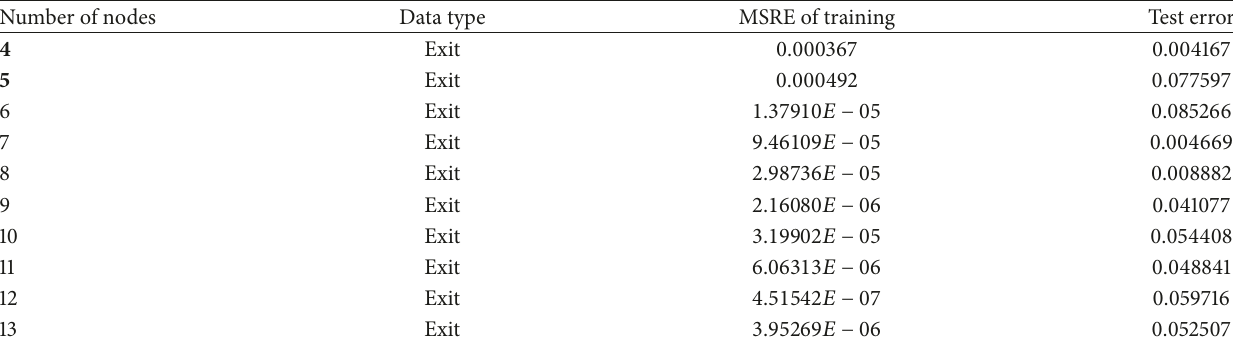
Table 6: Comparison 1 for selection test of number of hidden layer nodes.